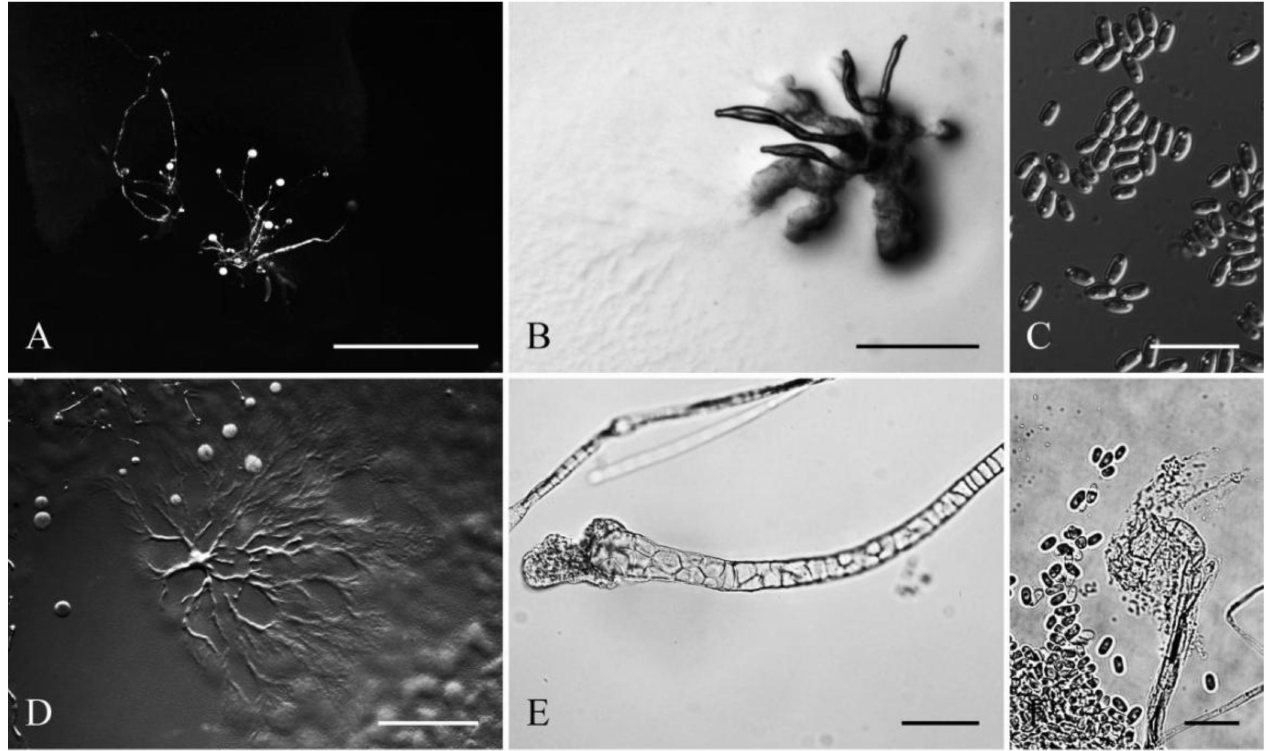
Figure 3. Morphological features of Cavenderia parvibrachiata (TH20C). ( A ), Sorocarps. ( B ), Clus- tered pseudoplasmodia. ( C ), Spores. ( D ), Aggregations. ( E ), Sorophore base. ( F ), Sorophore tip. Bars: ( A ) = 2 mm; ( B ) = 500 µ m; ( C ) = 20 µ m; ( D ) = 2 mm; ( E ) = 40 µ m; ( F ) = 20 µ